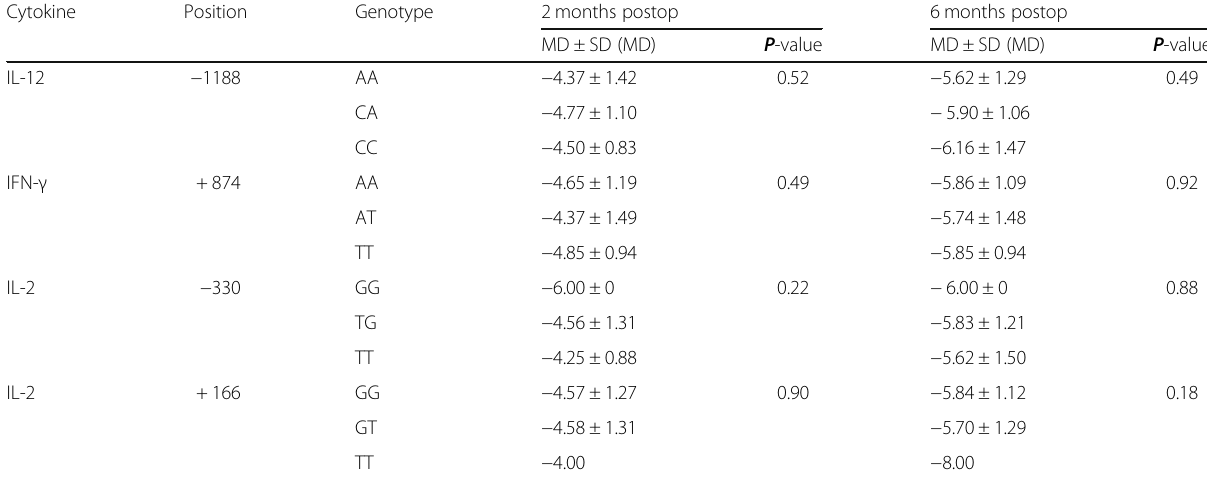
Table 4 Association between cytokine genotypes and 2 months or 6 months postop VAS changes in IVDD patients Cytokine